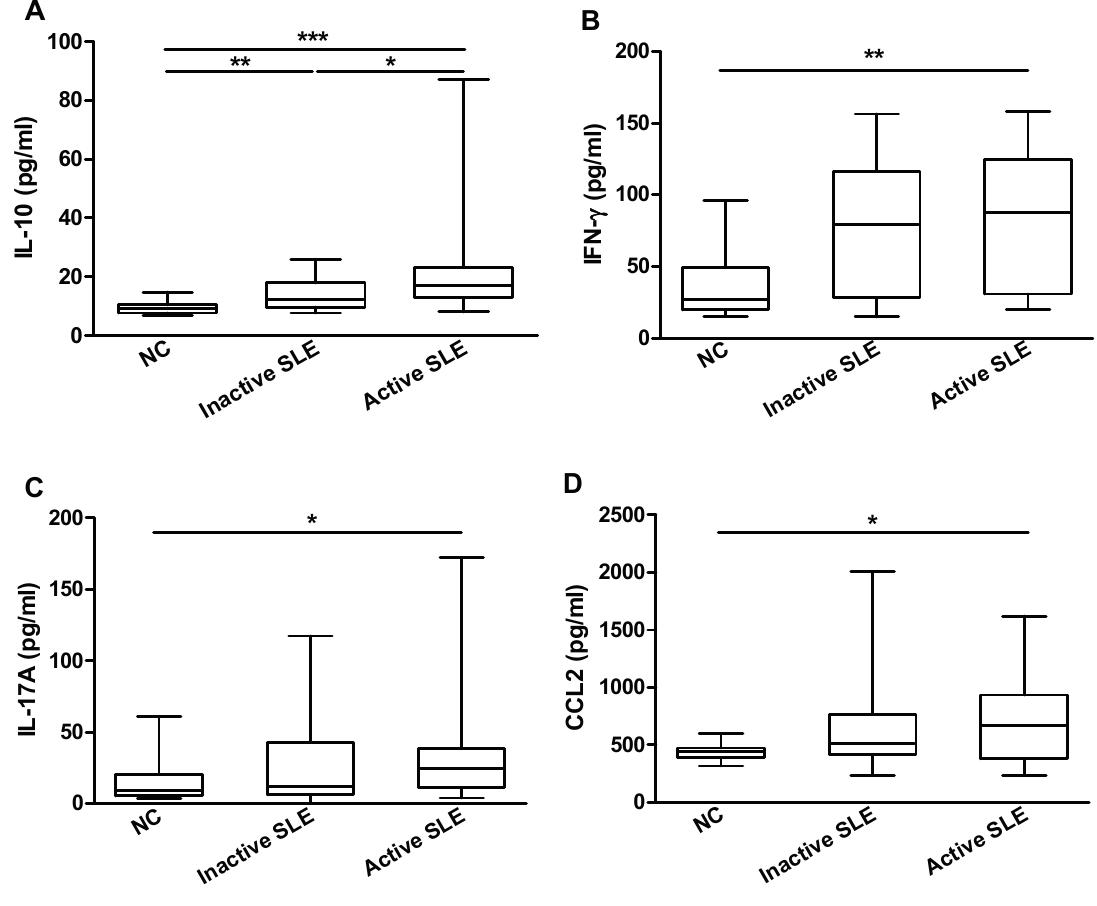
Figure 2. Comparison of plasma cytokines/chemokines concentrations between SLE patients and NC. Plasma concentrations of ( A ) IL-10; ( B ) IFN- γ ; ( C ) IL-17A and ( D ) CCL2 from inactive ( n = 22) and active ( n = 21) SLE patients and NC ( n = 16) were measured using Milliplex MAP assay kit. Results are presented as box and whisker plots with median (interquartile range). Statistical significances were indicated by * p < 0.05, ** p < 0.01 and *** p < 0.001 (Mann-Whitney U